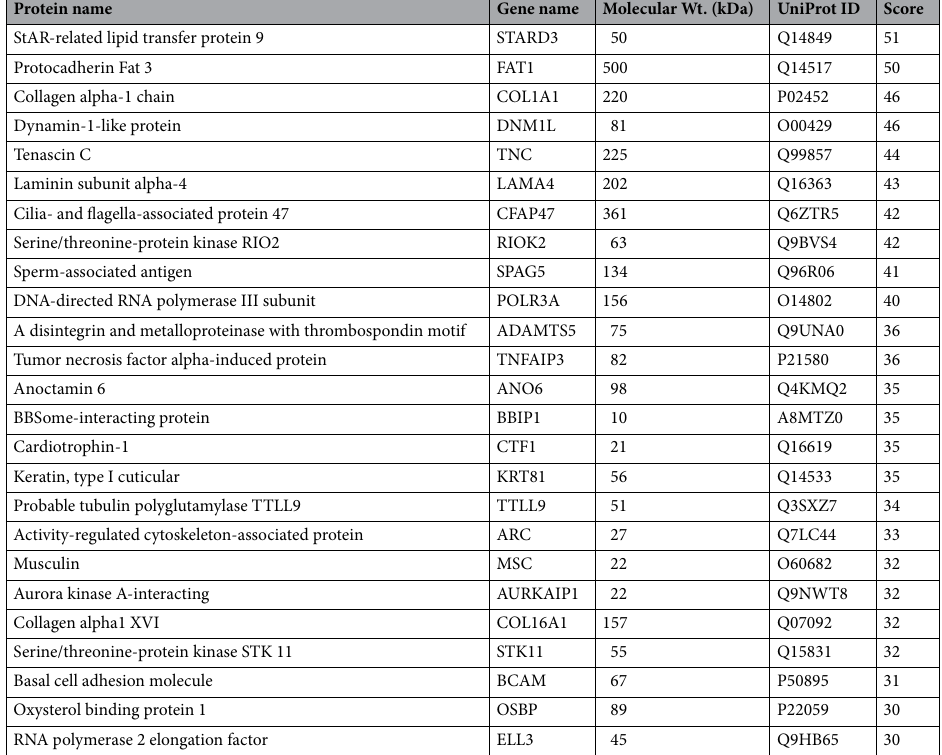
Table 3. β-Catenin Interacting Partners from Mild KC Corneal Epithelium using Co-IP/MS